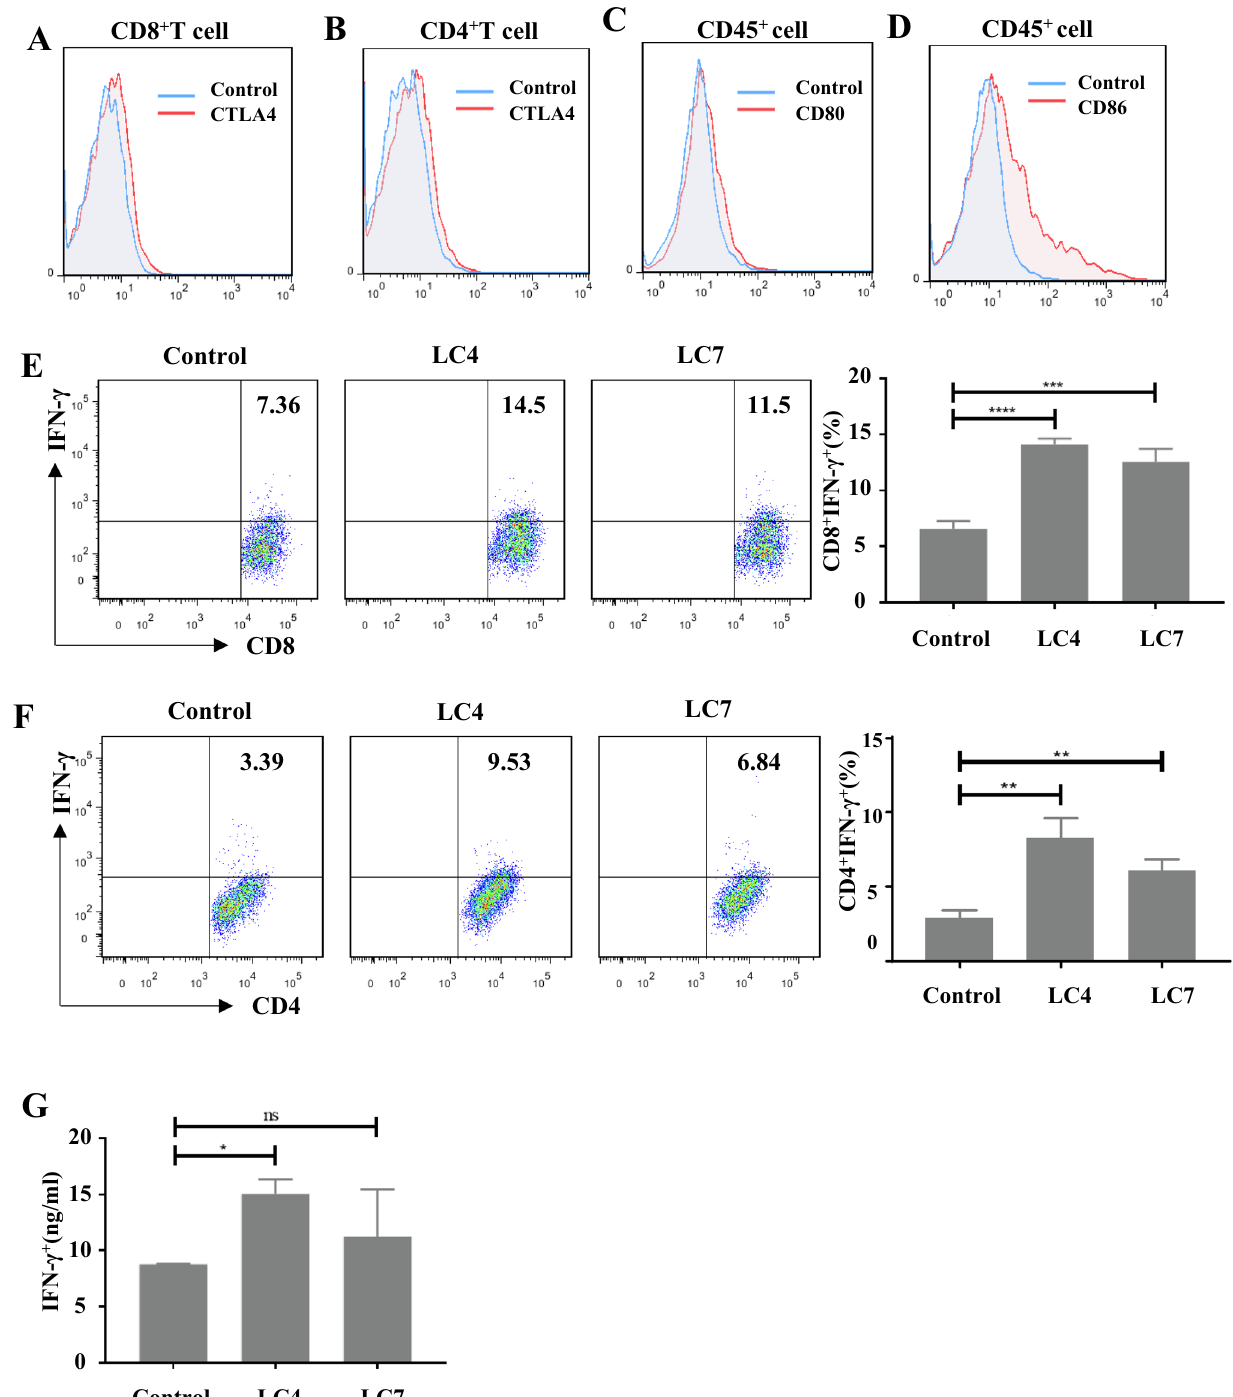
Fig. 4 CTLA-4 binding peptides activation on human T cells was determined in vitro. PBMC was added to a 48-well plate at 2 × 10. 5 cells/ well. Anti-Human CD (1 μg/ml) and CD (0.5 μg/ml) antibodies were added to stimulate T cell activation, then 200 μM CTLA-4 binding 3 28 peptide was added to the system and incubated in a 37 ℃ 5% CO for 3 days. The expression of CTLA-4 A - B , CD C and CD D in T cell acti- 2 80 86 vation experiment. Effects of CTLA-4 binding peptides on the percentage of E CD + IFN-γ + T cells and F CD + IFN-γ + T cells. G Elisa detects 8 4 the amount of IFN-γ in the cell culture supernatant. (ns = no significance, *p < 0.05, **p < 0.01, ***p < 0.001, ****p <